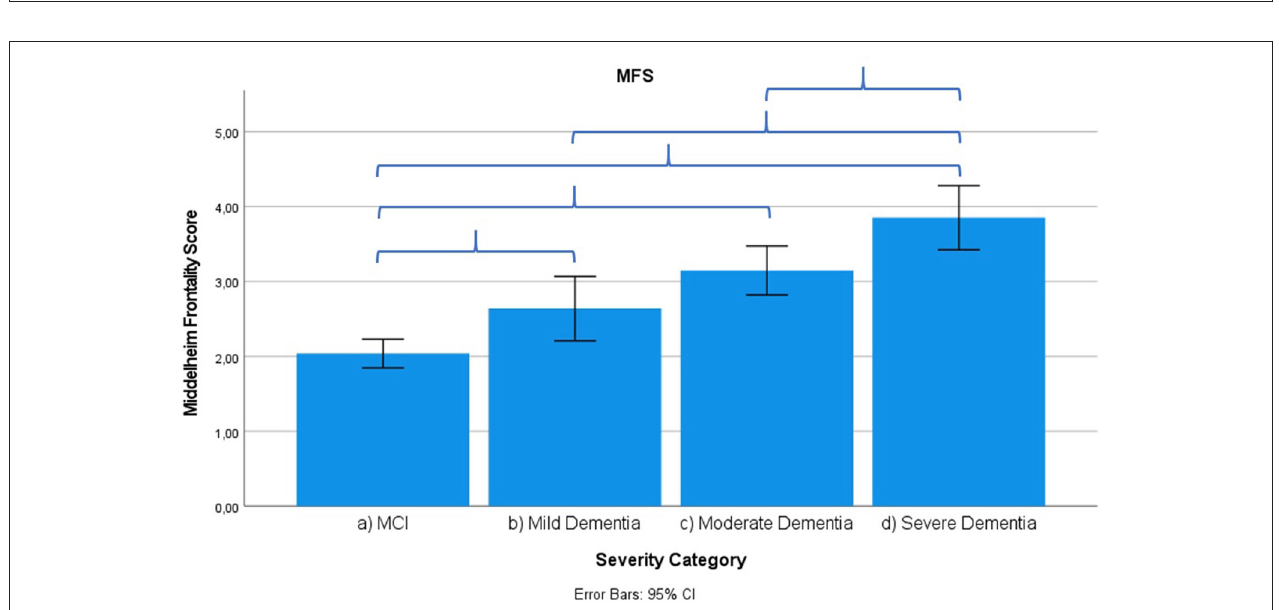
FIGURE 3 | Mean score on the Middelheim Frontality Score (MFS) scale according to severity of cognitive impairment. Error bars are 95% confidence interval. Curly brackets indicate p < 0.001.